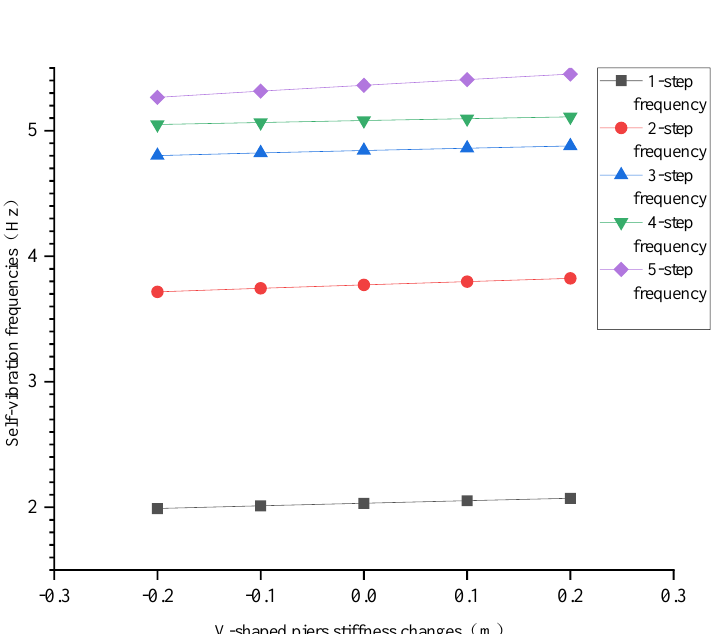
Figure 13. Self-vibration frequencies for different V-shaped pier stiffnesses of Structure II.